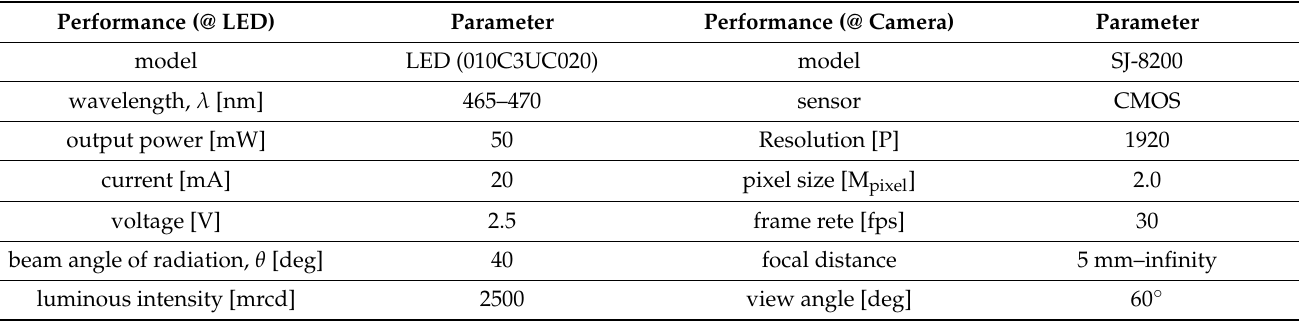
Table 2. Experimental device module